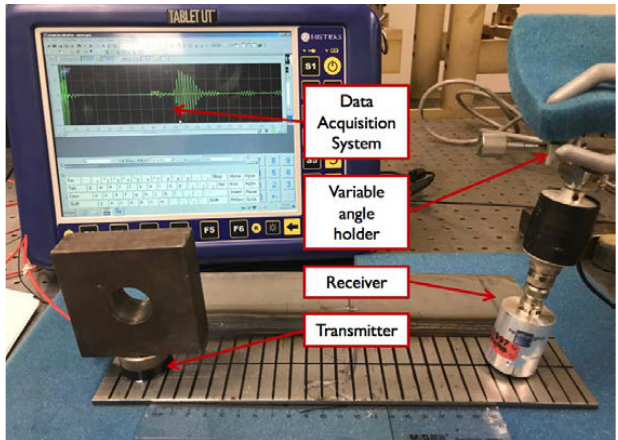
Figure 4. Experimental setup for the ideal angle identification.